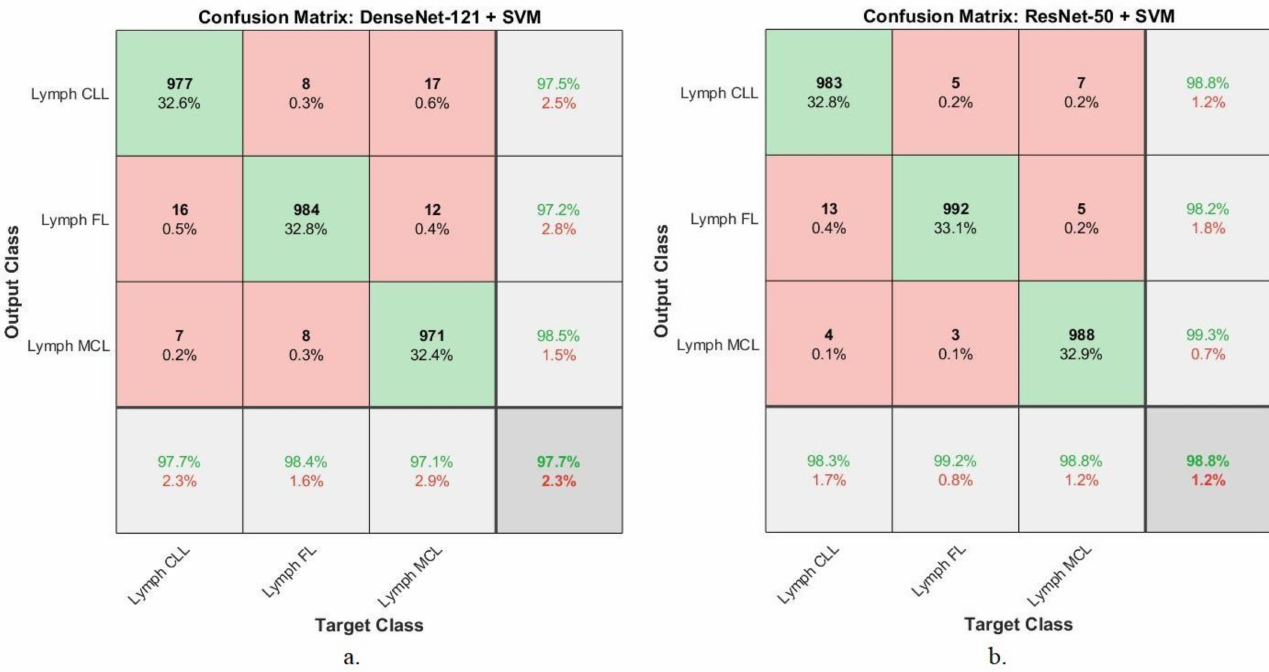
Figure 7. The confusion matrix to display the diagnosis of malignant lymphomas of first dataset by: ( a ) DenseNet-121 + SVM and ( b ) ResNet-50 +